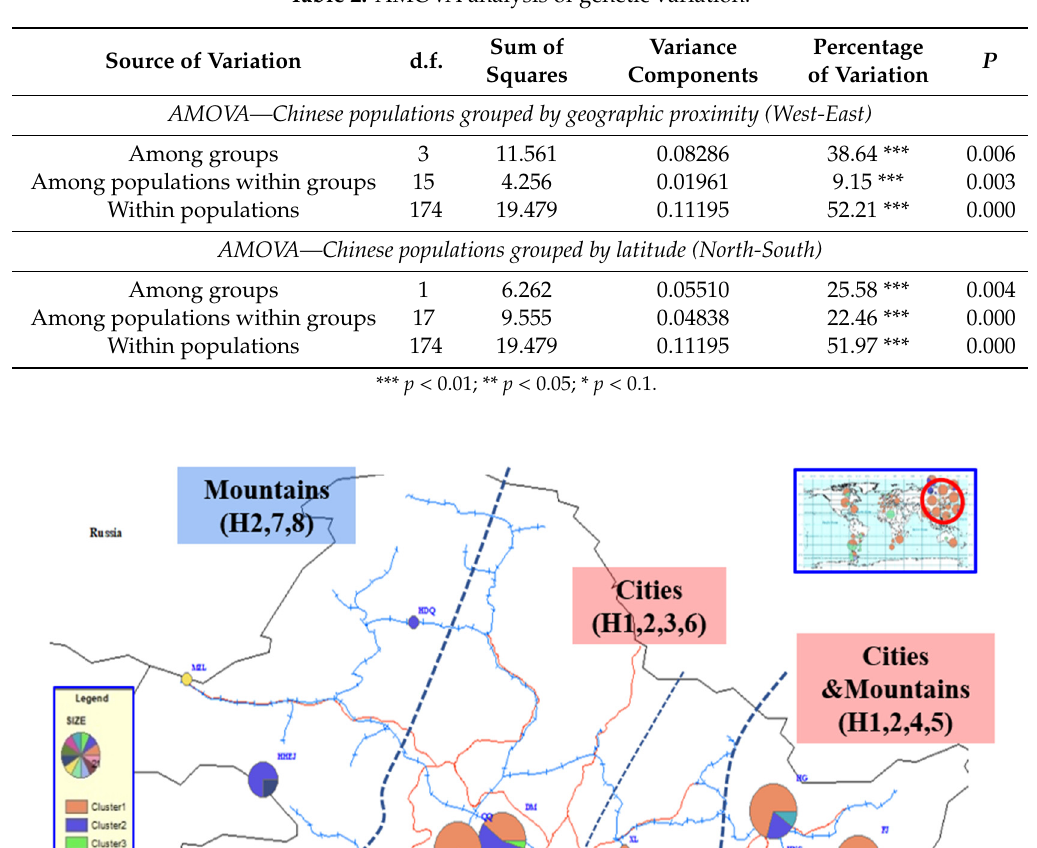
Figure 6. Chinese S. noctilio populations grouped by latitude (north to south) and their haplotype projections.